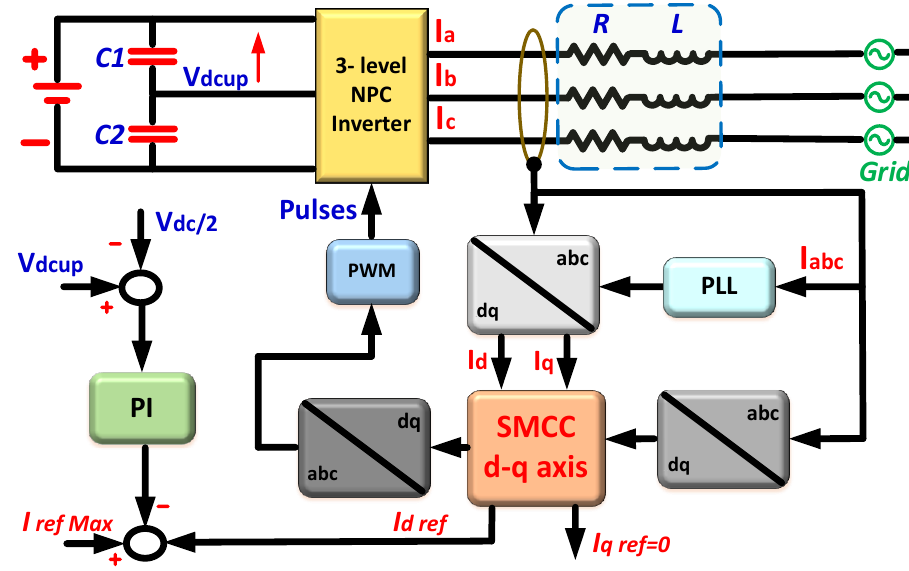
Figure 12. Direct current control (DCC) [137].